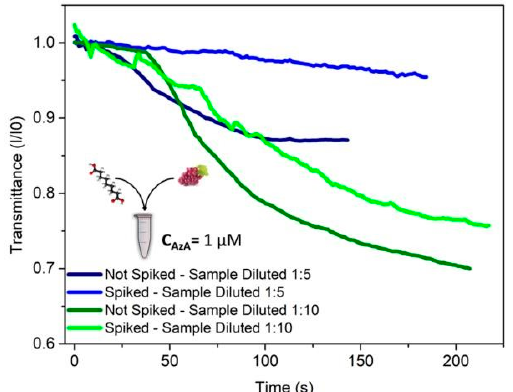
Figure 3. Detection of AzA in an artificially spiked sample of grape juice. The added concentration of AzA in the clarified grape juice was 1 µM. This mixture was then diluted in order to minimize the impact of matrix interferences from the grape juice itself. 35 µL of sample was added to 15 µL of a mixture of tyrosine and MBTH, resulting in final AzA concentrations of 140 and 70 nM. Measurements in raw grape juice was attempted (data not shown) but proved so far impossible to distinguish a contaminated from a non-contaminated sample due to the extent of the matrix